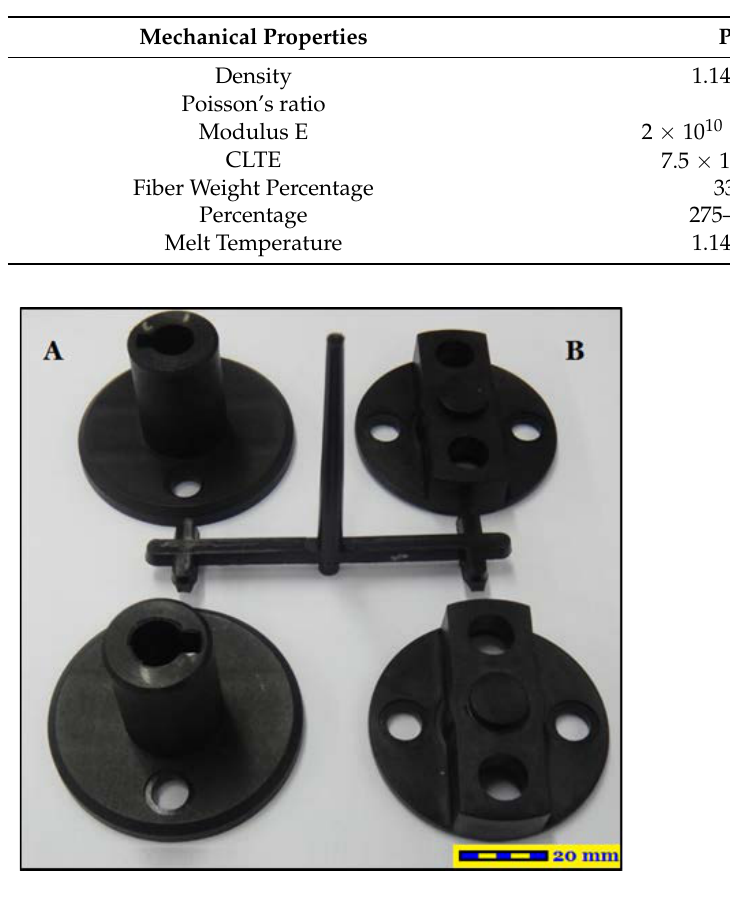
Figure 1. Photograph of a Car Lock Part. ( A ) Part A with the diameter and height 58 mm and 39.20 mm and ( B ) Part B with the diameter and height 54.95 and 18.11 mm.